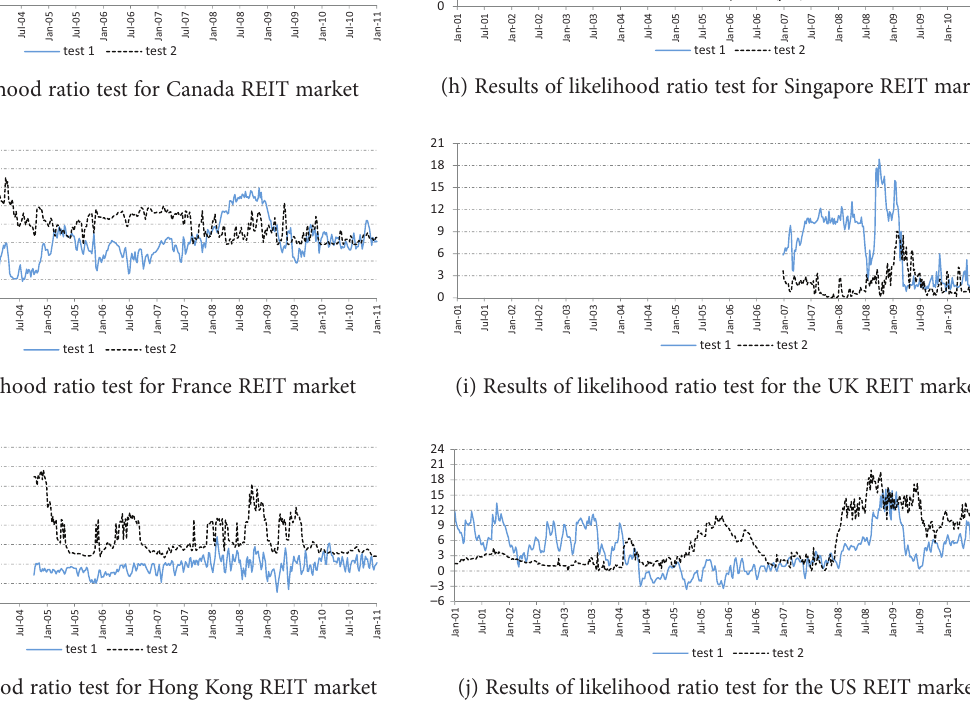
Figure 2. Results of likelihood ratio tests for 10 global REIT